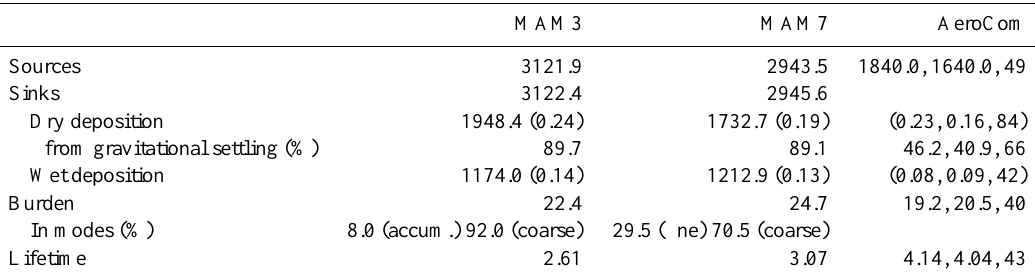
Table 7. Global budgets for dust. The means, medians and normalized standard deviations (in %) from available models participating in AeroCom (Textor et al., 2006) are listed. The values in parentheses are mean and median removal rates (in day − 1 ), and normalized standard deviations (in %) as budget terms are not given in Textor et al. (2006). For comparison, removal rates (in day − 1 ) from MAM3 and MAM7 are listed in parentheses.